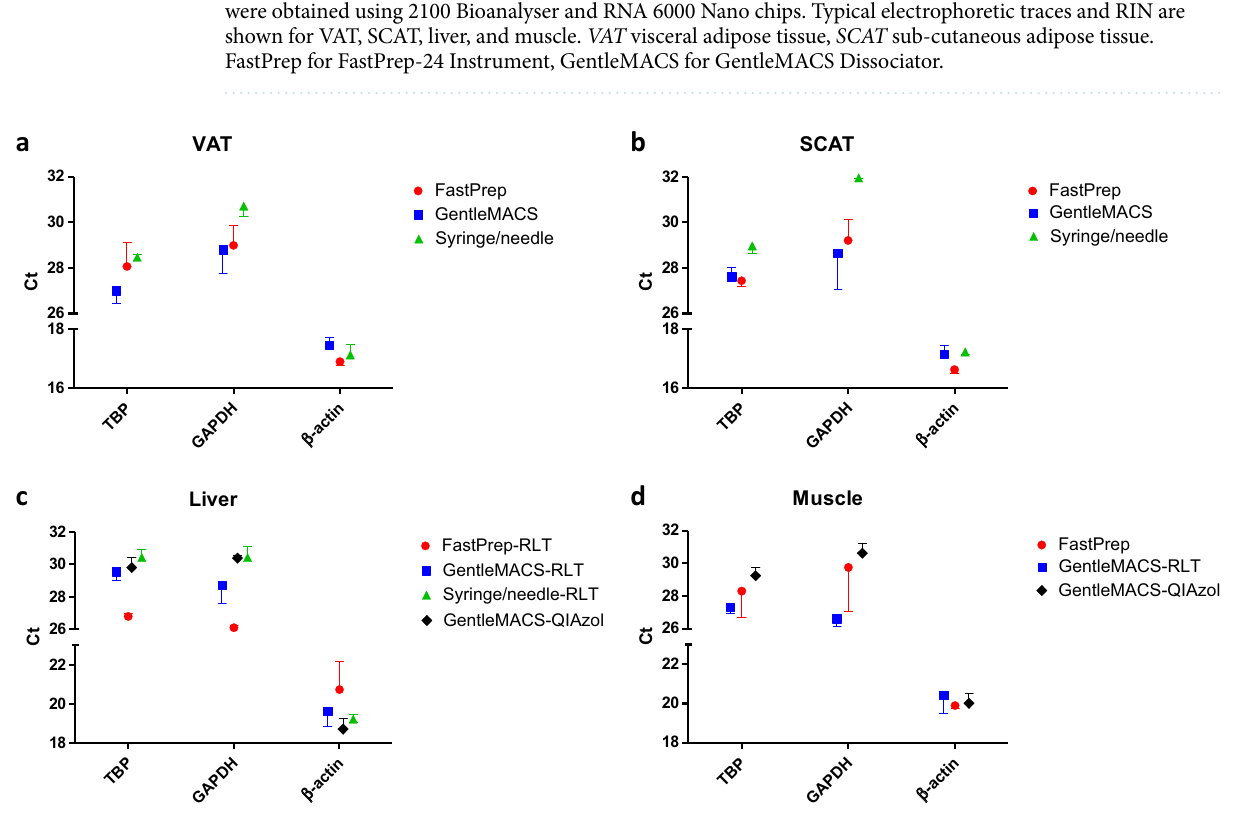
Figure 5. Quantification of mRNA of housekeeping genes according to homogenization buffers and methods used. RT-qPCR was used to amplify three housekeeping genes, TATA-box binding protein (TBP), glyceraldehyde-3 phosphate dehydrogenase (GAPDH), and β-actin. Mean Ct are shown for VAT ( a ), SCAT ( b ), liver ( c ), and muscle ( d ). VAT visceral adipose tissue, SCAT sub-cutaneous adipose tissue. FastPrep for FastPrep-24 Instrument, GentleMACS for GentleMACS